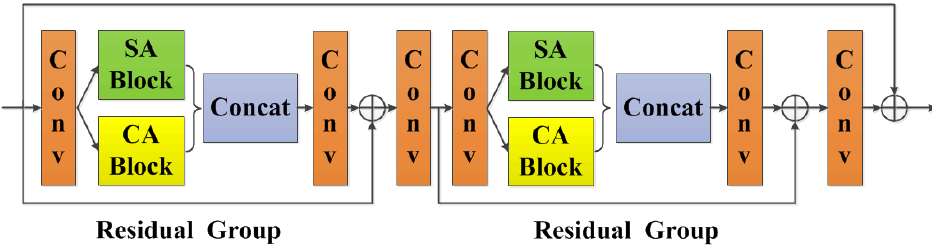
Figure 3. The residual spatial and channel attention module. Each “Conv” contains sequence Conv- BN-ReLU, “SA Block” refers to spatial attention block, and “CA Block” refers to channel attention block, “Concat” refers to concatenation. The kernel size of each convolution operation is 3 × 3, the stride is 1 × 1, and the padding is 1 × 1. Let C represent the channel number of the input feature maps, then the input and output channel numbers of 1st, 3rd, 4th and 6th convolution operations are C , and the input and output channel numbers of 2nd and 5th convolution operations are 2 × C and C , respectively.